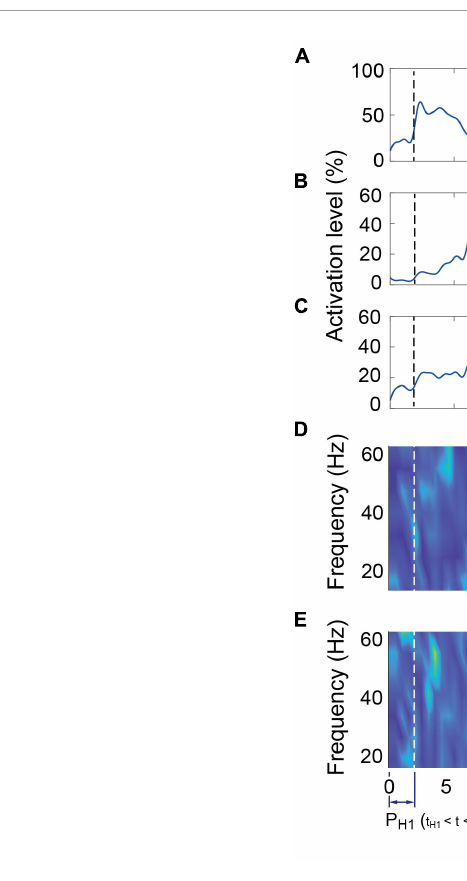
FIGURE6 Representative case of muscle activation and intermuscular coherence during task (Stroke subject 4, location 2, trial 1). (A–C) Activation profile of EDC, FDS, and BB. (D–E) Time-frequency plot of intermuscular coherence of EDC-BB and FDS-BB pairs. Increase in the intermuscular coherence in the β - (13–35 Hz) and low γ - (36–55 Hz) bands was mainly observed during early phase of the reaching movements toward the target (i.e., the first half of P H3 ), which was followed by an increase in the activation of the distal muscles (EDC and FDS). Such patterns were not observed at near-body location (i.e., during P H1 ) (EDC, extensor digitorum communis; FDS, flexor digitorum superficialis; BB, Biceps